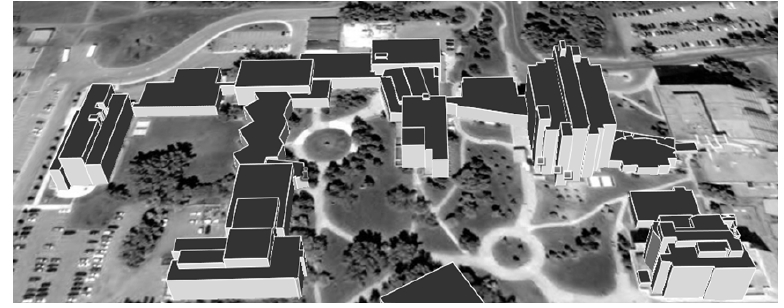
Figure 15. DBM (in KML format) produced through the automated building reconstruction process is imported into Google